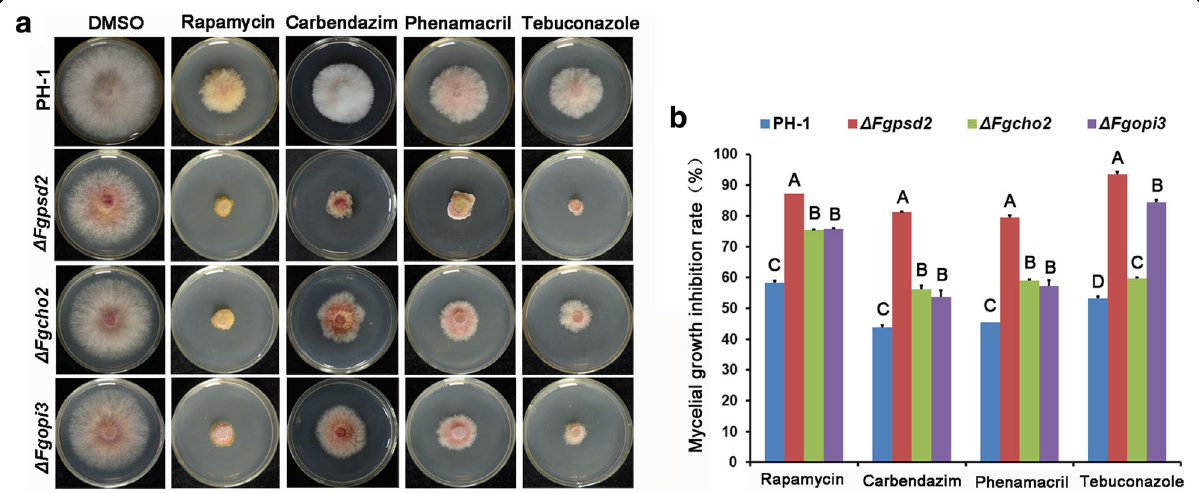
Fig. 4 Disruption of phospholipid biosynthetic genes leads to increased sensitivity to multiple antifungal agents. a Inhibition of mycelial growth of the wild-type and mutant strains by each antifungal agent. Strains were grown on CM amended without or with tebuconazole, carbendazim, phenamacril or rapamycin at the concentration indicated in the methods section. Images were obtained when the mycelia of the wild-type strain reached the edge of the plate. b Percentage of mycelial growth inhibition by each antifungal agent in each strain. The vertical lines on the bars in each column denote the standard deviations of three repeated experiments. The values corresponding to the bars denoted with the same letter are not significantly different according to the (LSD) test at P =